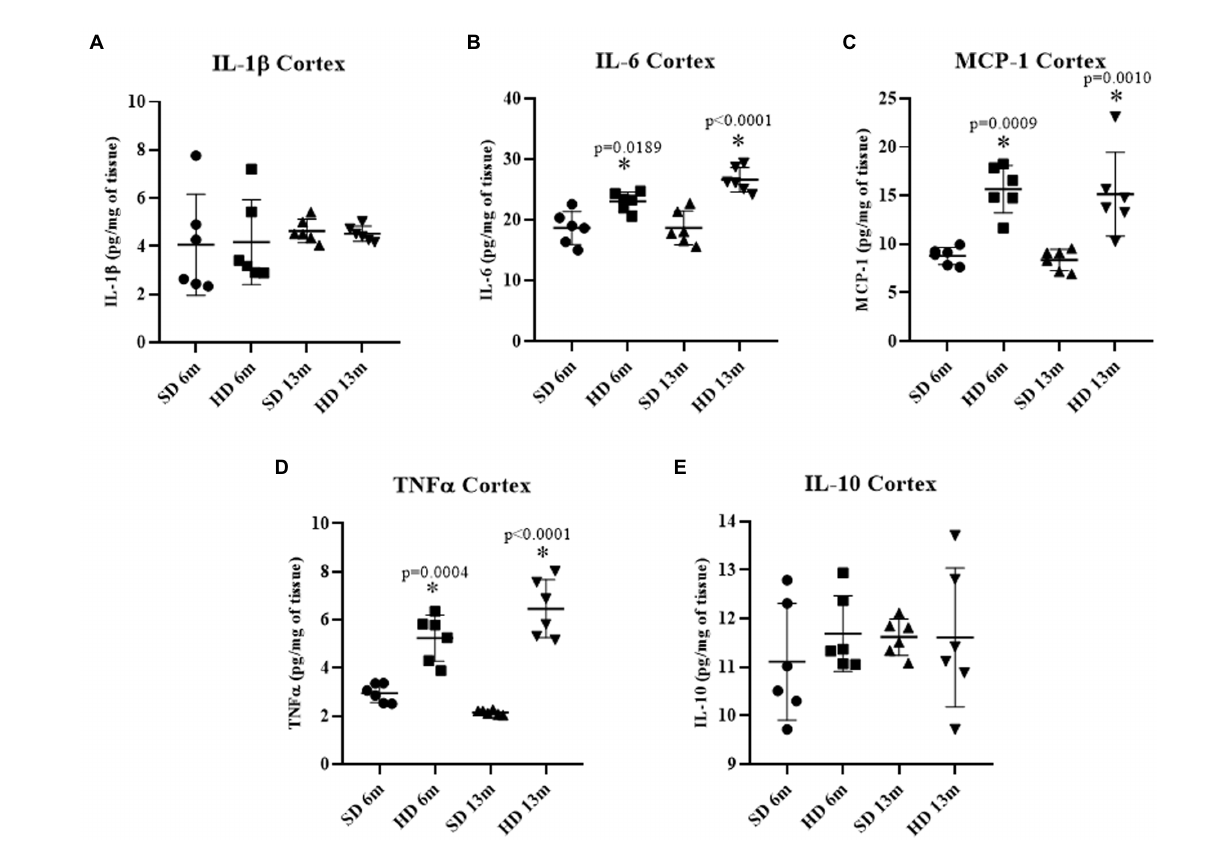
FIGURE 3 Cerebral cortex inflammatory profile. The levels of IL1 β (A) , IL6 (B) , MCP-1 (C) , TNF α (D) , and IL10 (E) were analyzed by ELISA ( n = 6 SD and n = 6 HD). The data represent the mean ± SD and were analyzed by two-way ANOVA, followed by Tukey’s post hoc test. The significant differences between groups compared to the SD are marked with ∗ p <